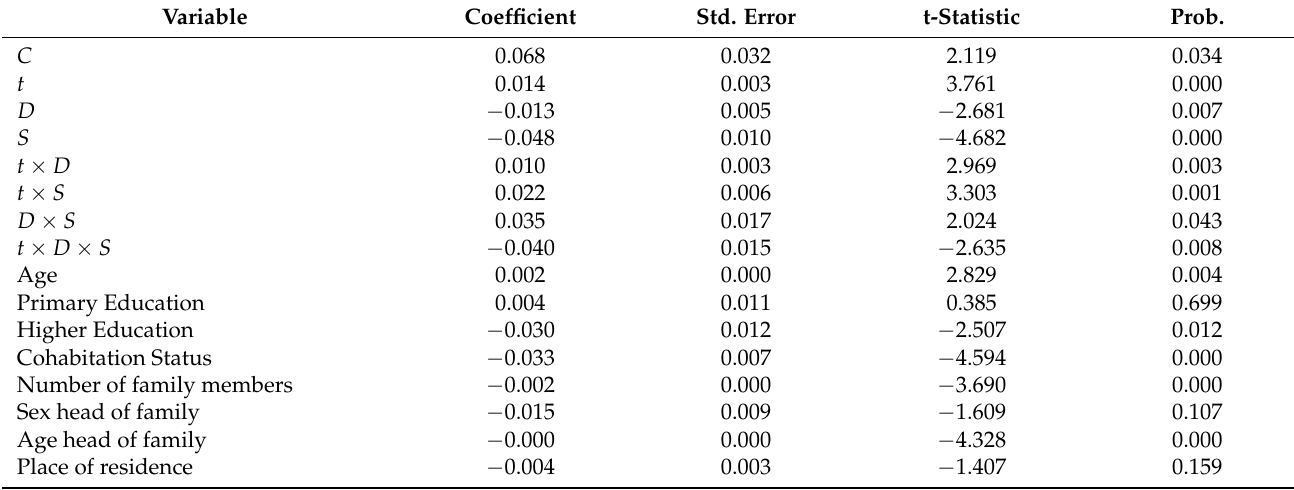
Table 3. Differences-in-differences (DID) estimates of the effect of the earthquake on the probability of being seropositive. Variable Coefficient Std.